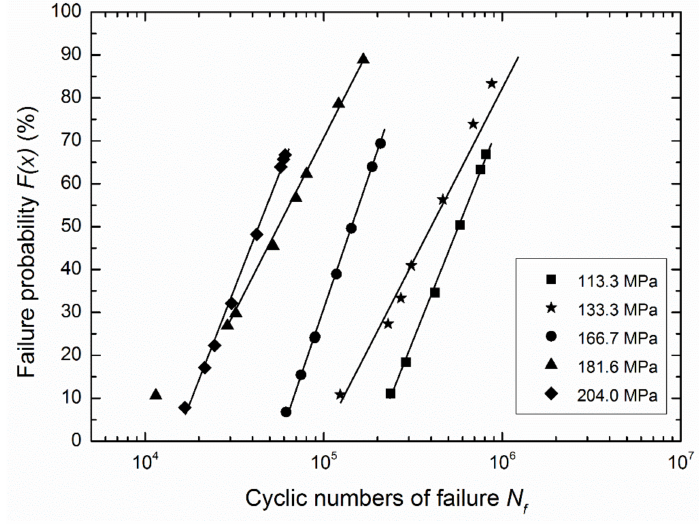
Figure 11. Failure probability varies with cyclic numbers of failure for 7075-T7351 Al alloy under different stress amplitudes in